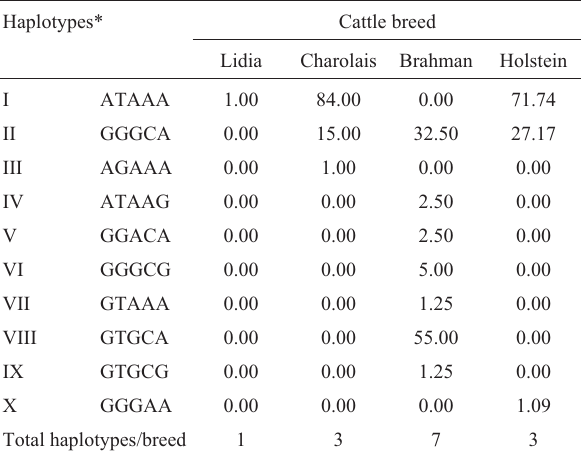
Table 3 - Haplotype frequencies for DBHb in four cattle breeds.